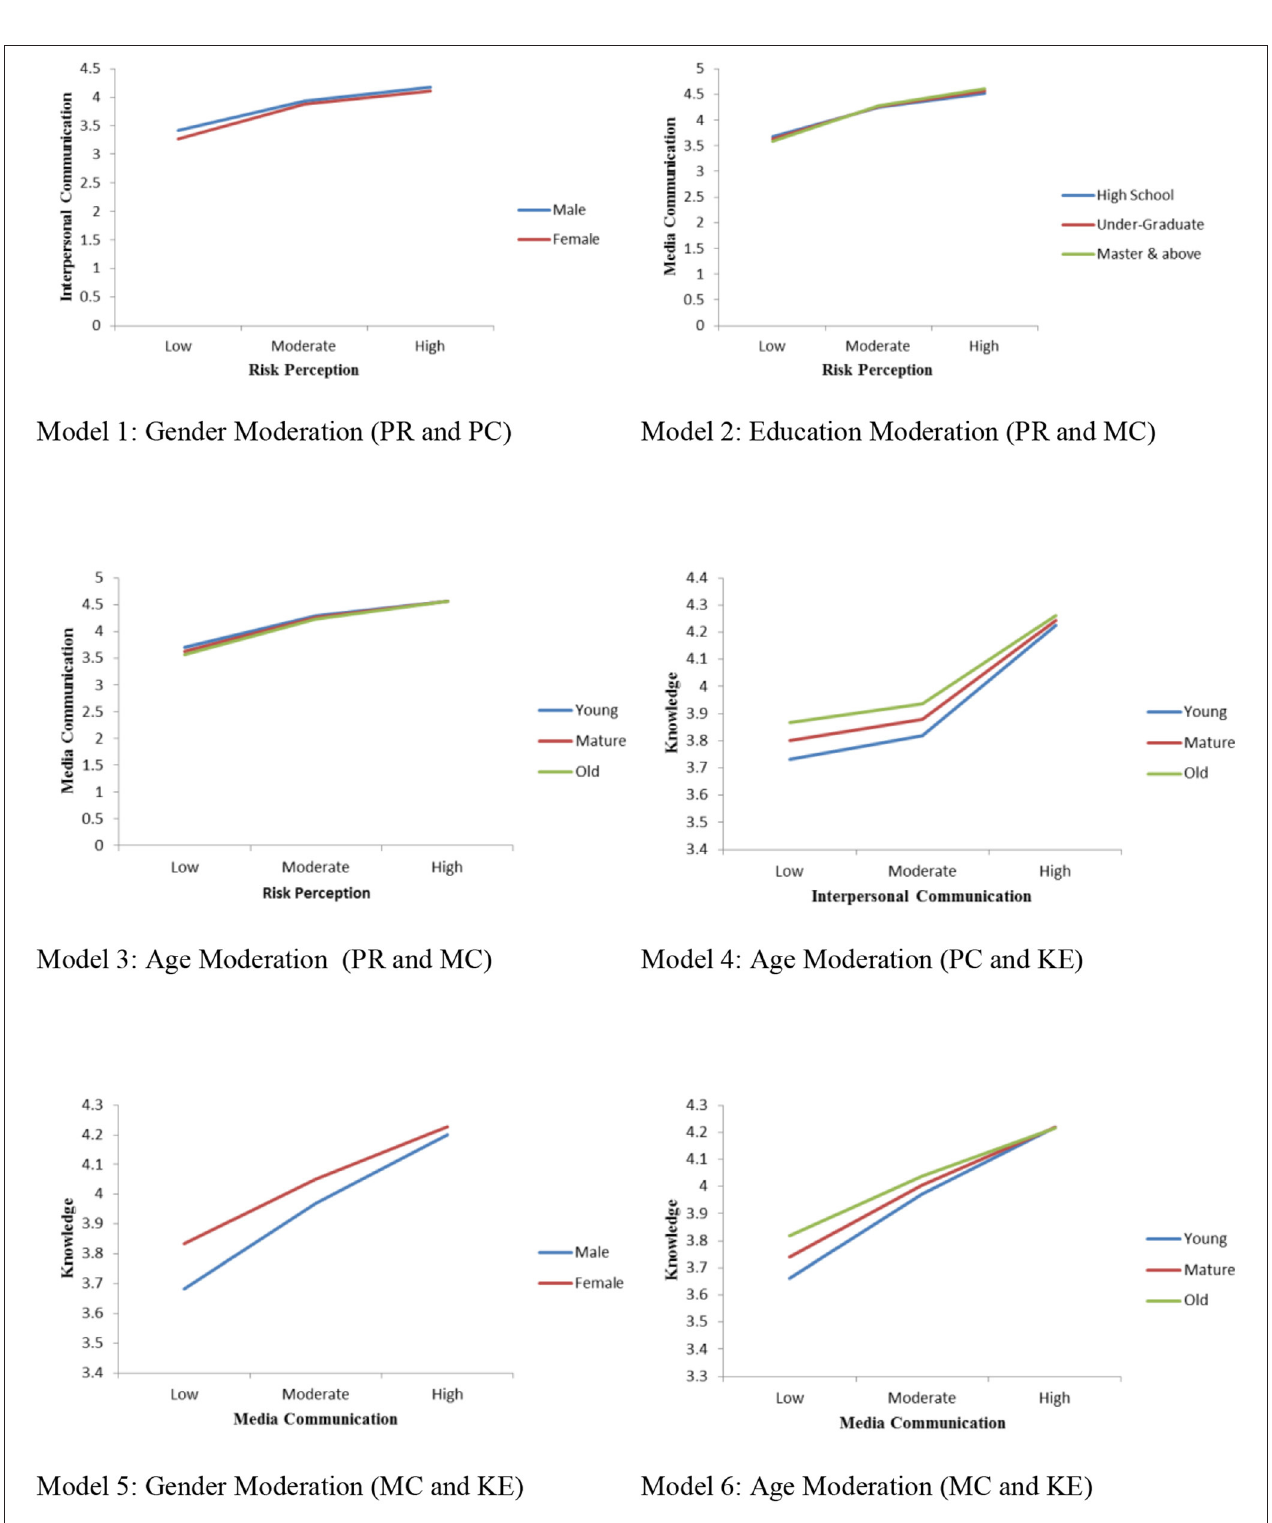
FIGURE 3 | Moderation